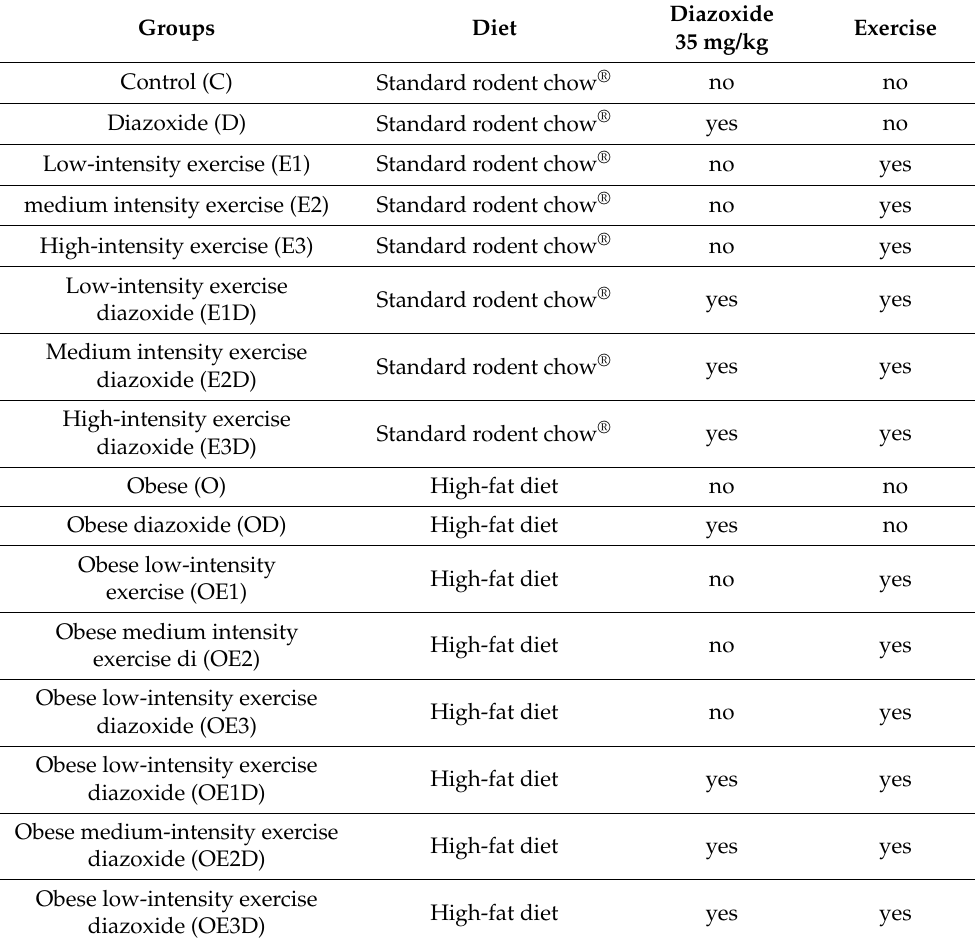
Table 1. Experimental